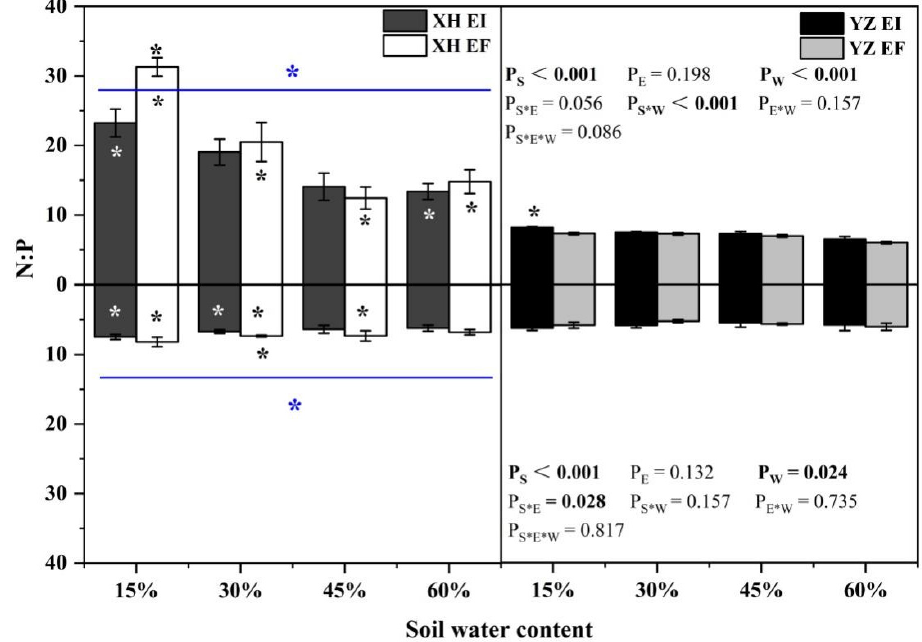
Figure 12. The N:P content of A. inebrians seedlings shoots and roots from XH(W) and YZ(D) seeds under various soil water content. Upwards and downwards bars represent the value of shoot and root part, respectively. The asterisk (*) above/below error bars means significant difference ( p < 0.05) between EI and EF under the same soil water content. White/black * in the dark gray/white bars indicates significant difference ( p < 0.05) between Xiahe and Yuzhong maternal habitat type of EF/EI grasses. The blue * above/below full blue line indicates significant difference ( p < 0.05) between Xiahe and Yuzhong maternal habitat type.